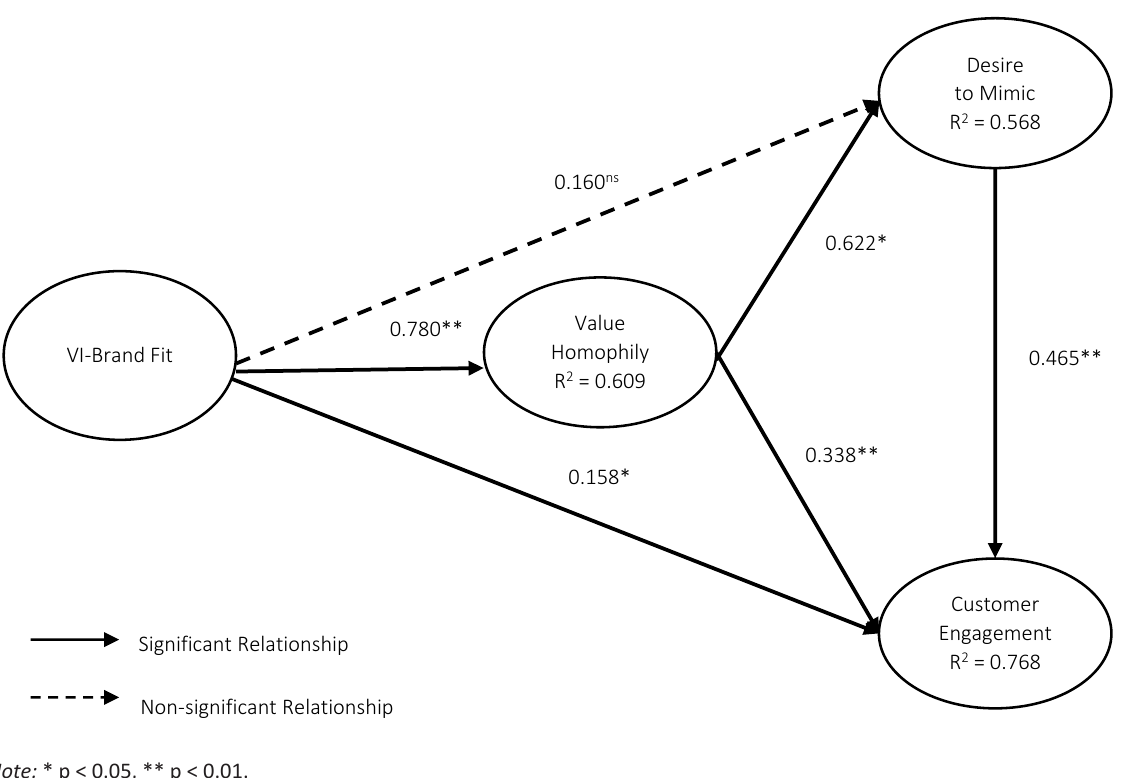
Figure 1. Model fit of path